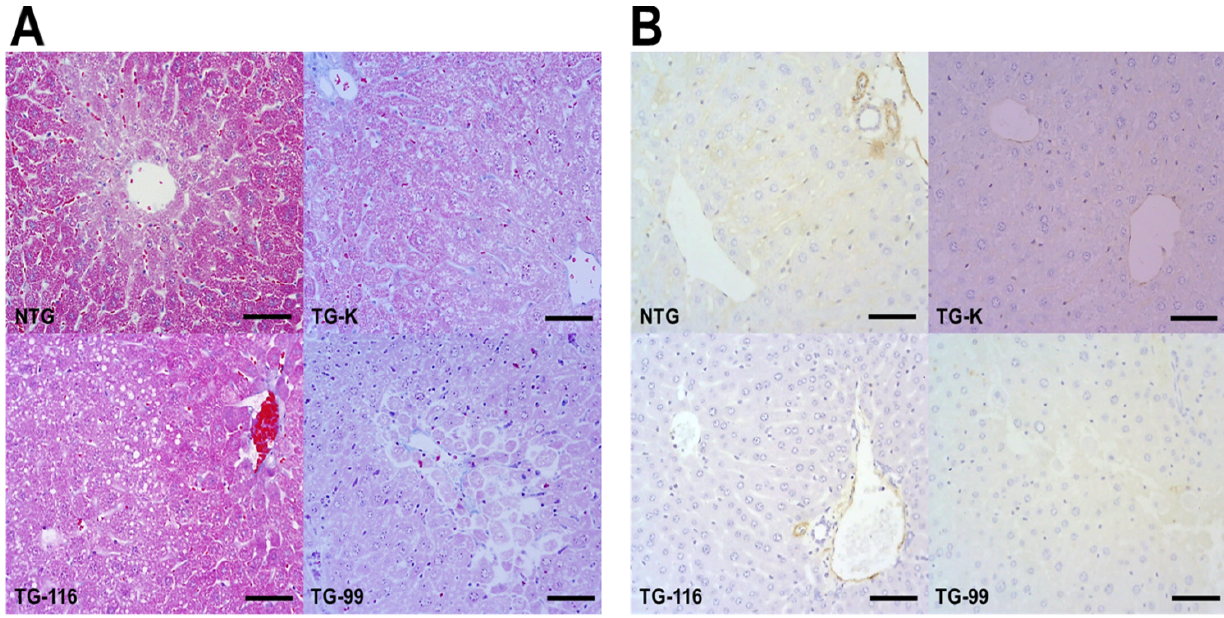
Figure 2. ( A ) Azan-Mallory staining. Scale bar = 50 μ m; ( B ) Immunohistochemistry staining of α -Smooth muscle actin ( α -SMA). Scale bar = 50 μ